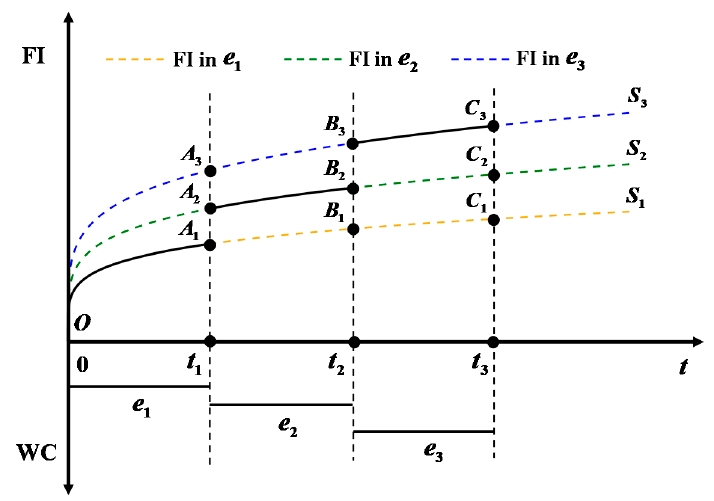
Figure 1. FIs in three different WCs.